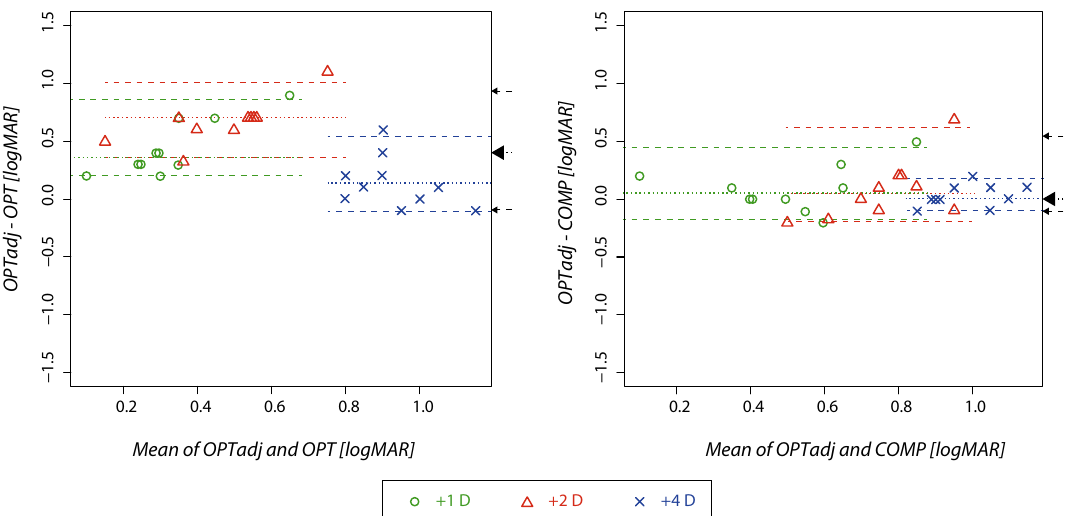
Figure 1. Bland–Altman 15 plot compares measured VA between the OPT and OPTadj methods (left panel) and the COMP and OPTadj methods (right panel). Along the horizontal axis, the mean, and along the vertical axis, the difference of two VA measurements are plotted. Every point corresponds to a single participant and the symbols and colors differentiate the blur levels. The horizontal dotted lines represent the median difference between the two compared methods and the dashed lines indicate the limits of agreement (2.5–97.5 quantile range). The medians and limits of agreement are depicted separately for the particular level of blur, the arrows on the right side of plot indicate the median and limits of agreement for all values irrespective of the blur level. Results of dioptric blur using a direct addition of + 1 and + 2 D lenses ( OPT method) were biased toward a higher VA (lower logMAR). The rendered blur approach ( COMP method) was not statistically different from the adjusted dioptric approach ( OPTadj method)—see Table 2.